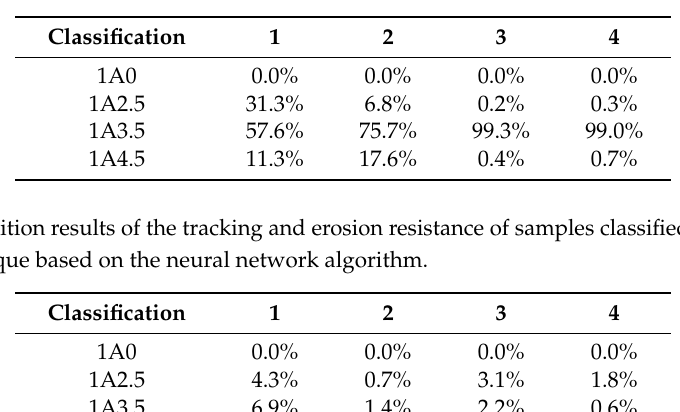
Table 8. Recognition results of the tracking and erosion resistance of samples classified as 1A3.5 using the LIBS technique based on the neural network algorithm.